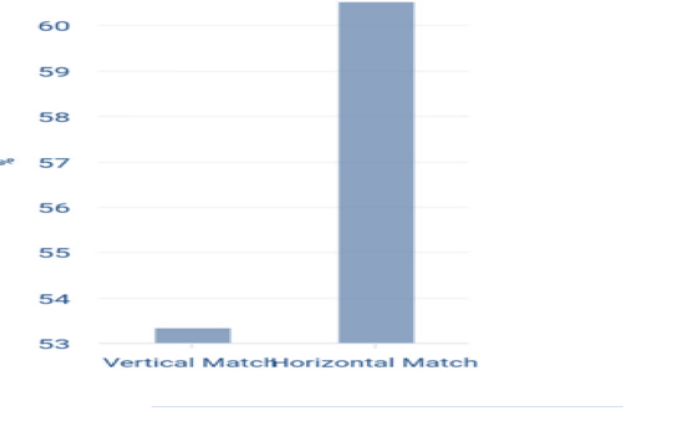
Figure 2: Education level and low wages (vertical mismatch) and workers and employment mismatch with education level and wages (horizontal mismatch upah (horizontal mismatch); Source: 2015 National Labor Force Survey processed by the Demographic Institute of the University of Indonesia in Mahdiyah